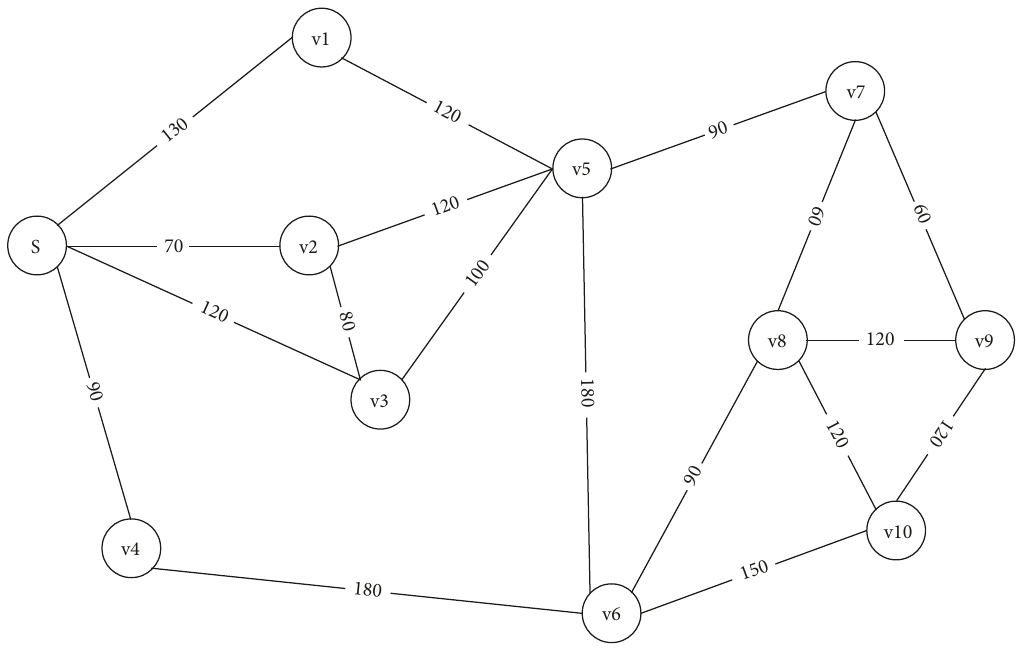
Figure 2: A route